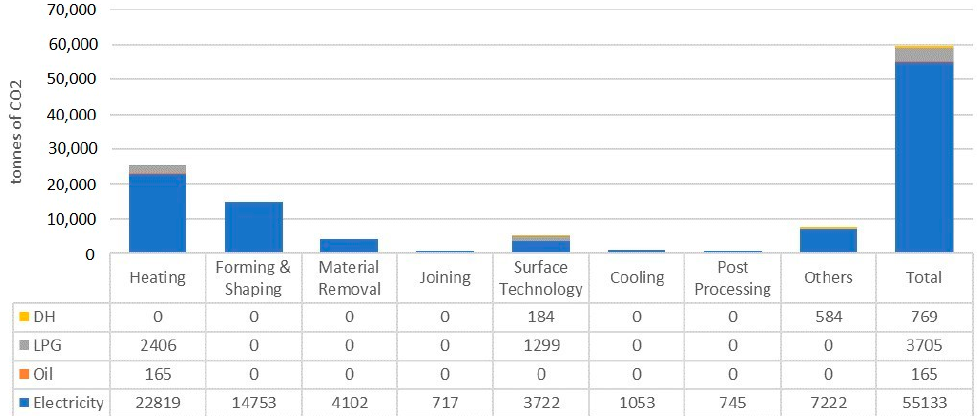
Figure A2. CO 2 emissions for the unit processes in the production category based on the case study of the Swedish engineering industry (Scenario 1).